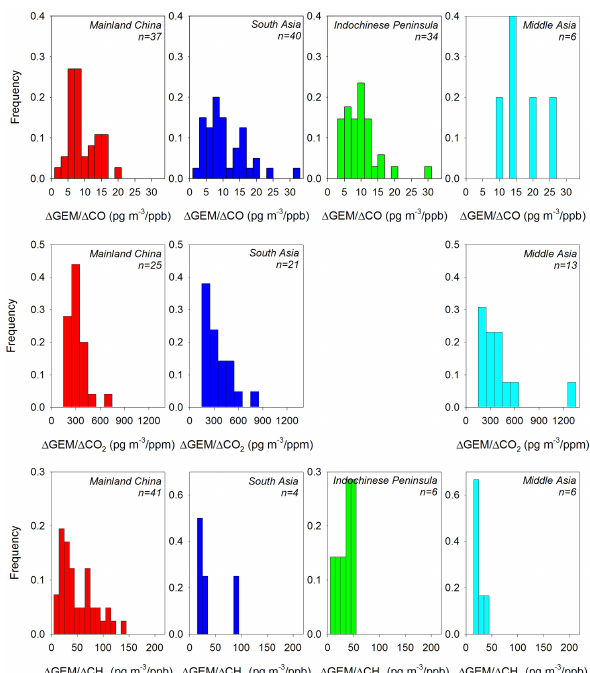
Figure 3. Histograms of the correlations slopes of GEM/CO, GEM/CO 2 , and GEM/CH 4 for the four Asian regions during the whole study period. All the correlation slopes meet the selection criteria (see